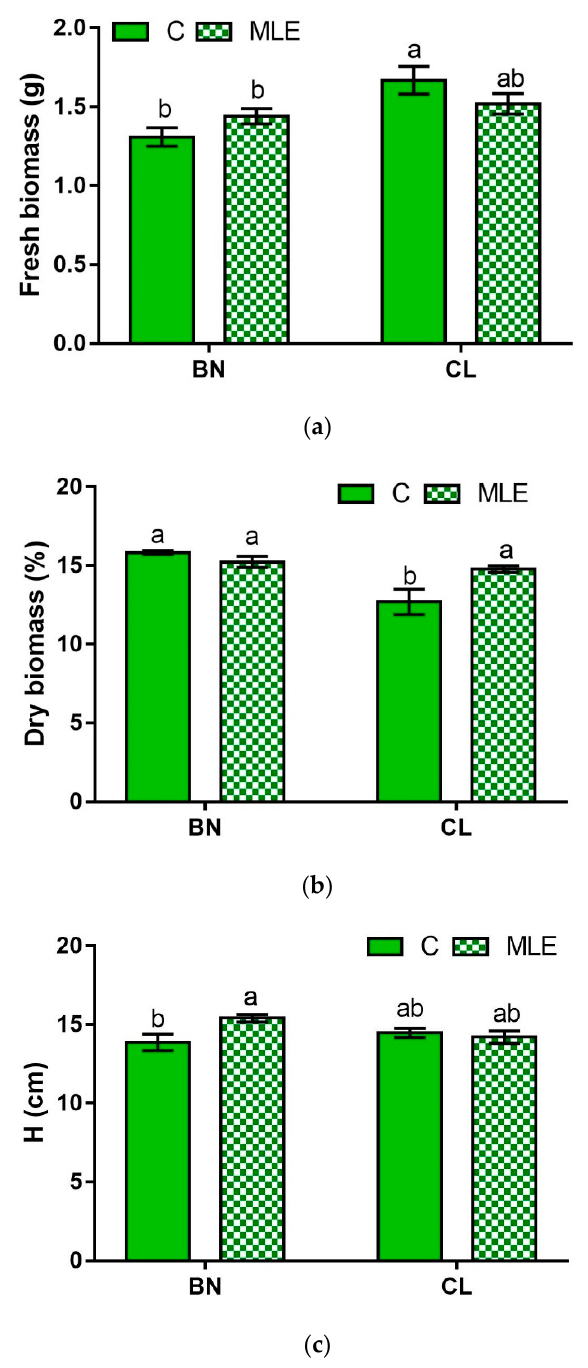
Figure 2. Effect of interactions of fresh (g) ( a ) and dry biomass (%) ( b ), height (cm) ( c ) from leaves of BN and CL treated with distilled water (C) and MLE. Values are the means ± SE ( n = 9). Different letters: statistically significantly different means for p < 0.05 (LSD test).